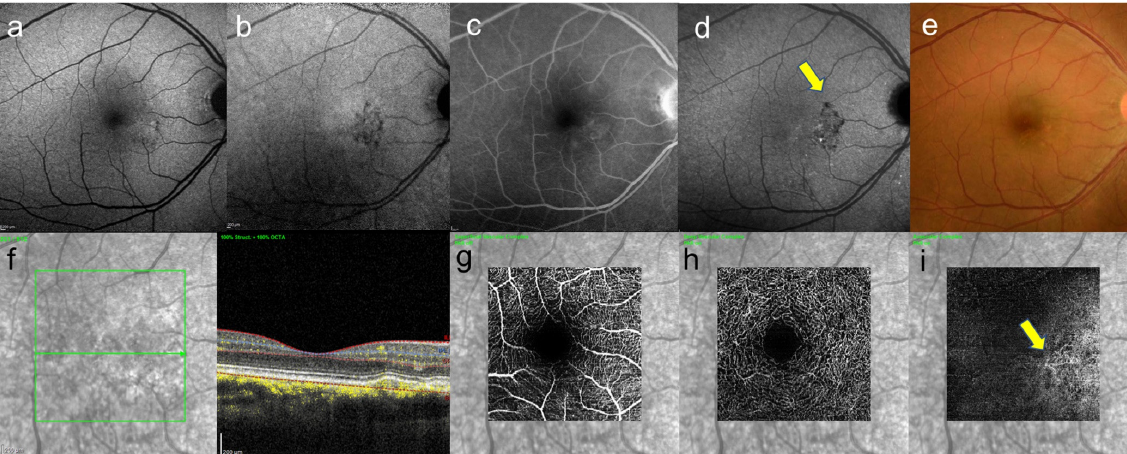
Figure 7. A 46-year-old man with unilateral CSC. These images are the eye without serous retinal detachment, contralateral eye. ( a ) short-wavelength fundus autofluorescence image, hyperautofluorescence and hypoautofluorescence near the fovea can be seen, ( b ) near-infrared autofluorescence image, hypoautofluorescence near the fovea can be seen, ( c ) FA image acquired at 22 min, slight staining was observed and ( d ) ICGA image acquired at 27 min, abnormal hypofluorescence can be seen (arrows) which corresponds to the hypofluorescent foci in near-infrared autofluorescence image, ( e ) color fundus photograph, pigmentation irregularity can be seen, ( f ) infrared + OCT (horizontal section) through the fovea. There is no serous retinal detachment but flat irregular RPE is found, ( g ) superficial vascular segment OCT angiography, ( h ) deep vascular segment OCT angiography, ( g , h ) there is no macular neovascularization, ( i ) avascular segment OCT angiography, where there is macular neovascularization (arrow).